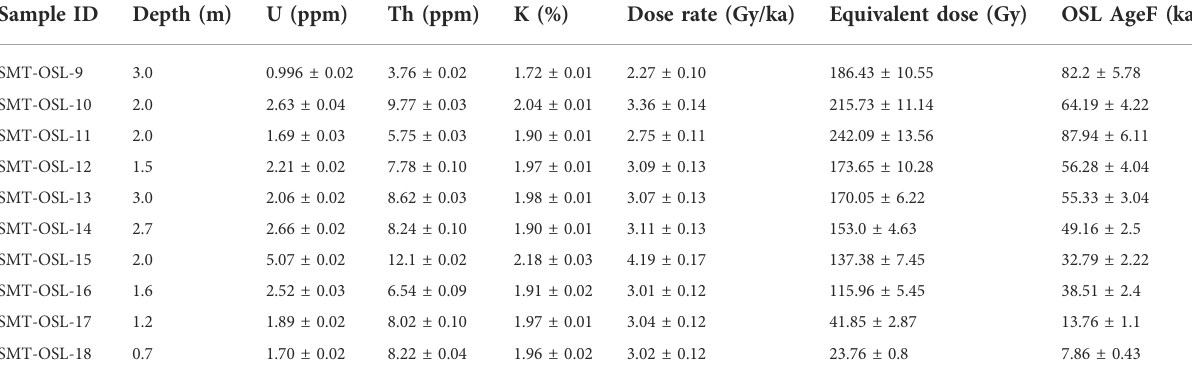
TABLE 1 Dating results from Optically Stimulated Luminescence (OSL) samples.